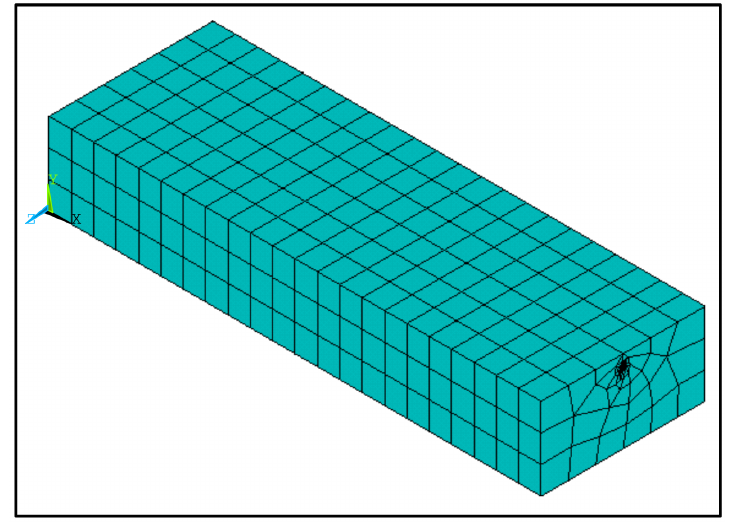
Figure 2. Grid division of faulted